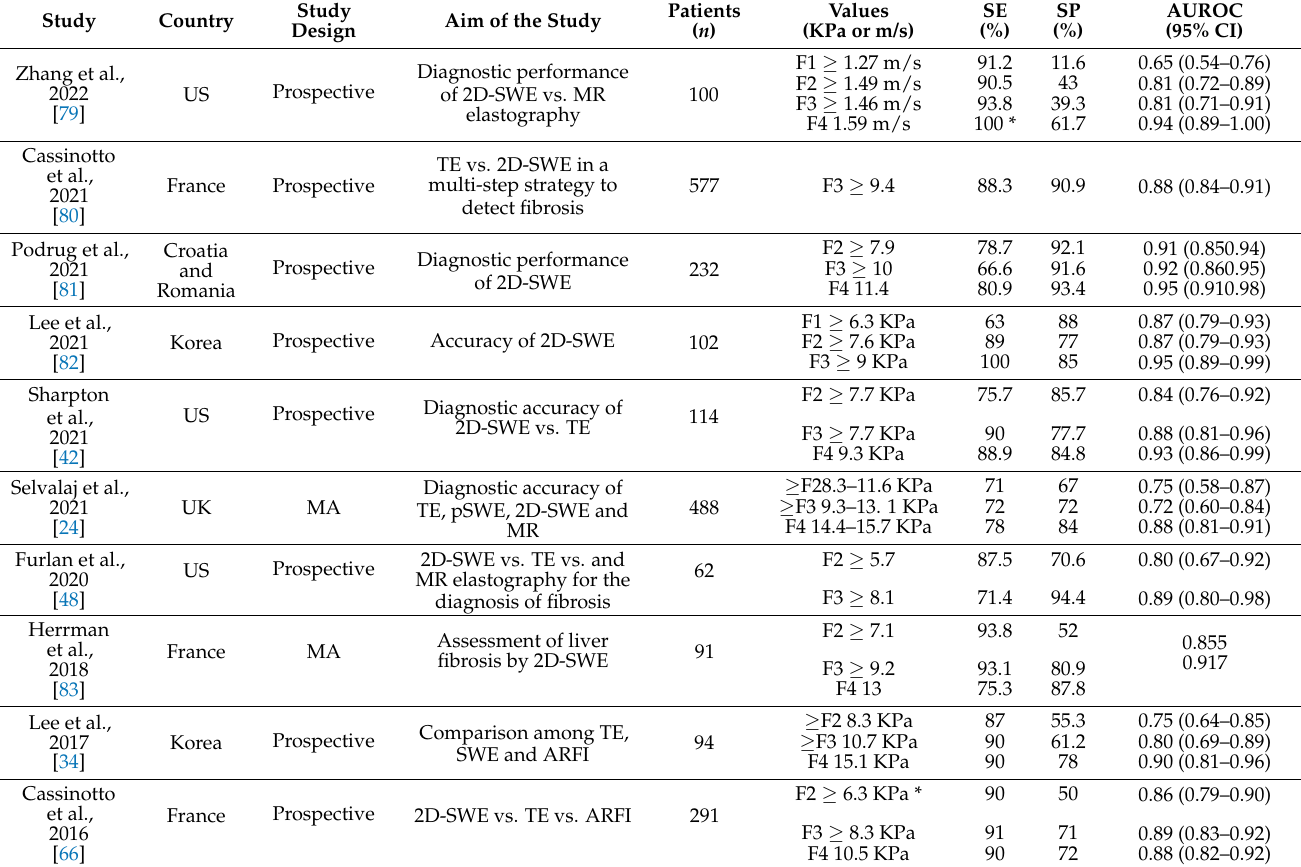
Table 3. Studies published in the last 10 years addressing the use of 2D-shear wave elastography in NAFLD